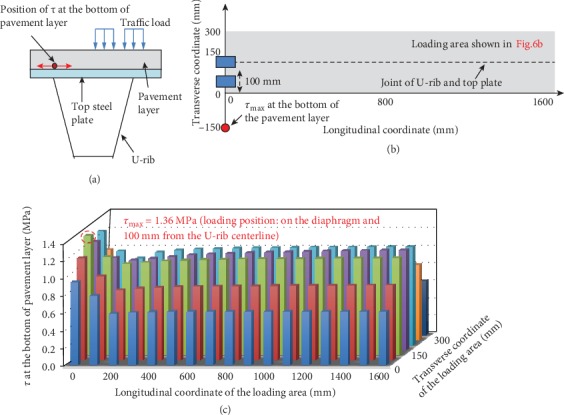
(a) The location of τ, (b) the location of τmax and the corresponding loading position, and (c) the change of τ with the change of loading positions.